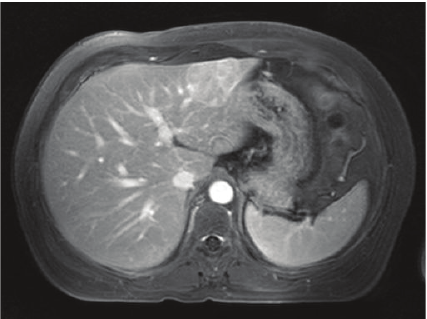
Figure 2: An example of a woman with a HCA of 4.2 cm in segment 2/3 in which pregnancy will not be